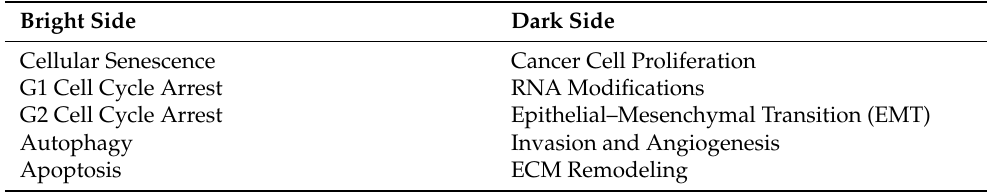
Table 1. The bright and the dark sides of TGF- β signaling in